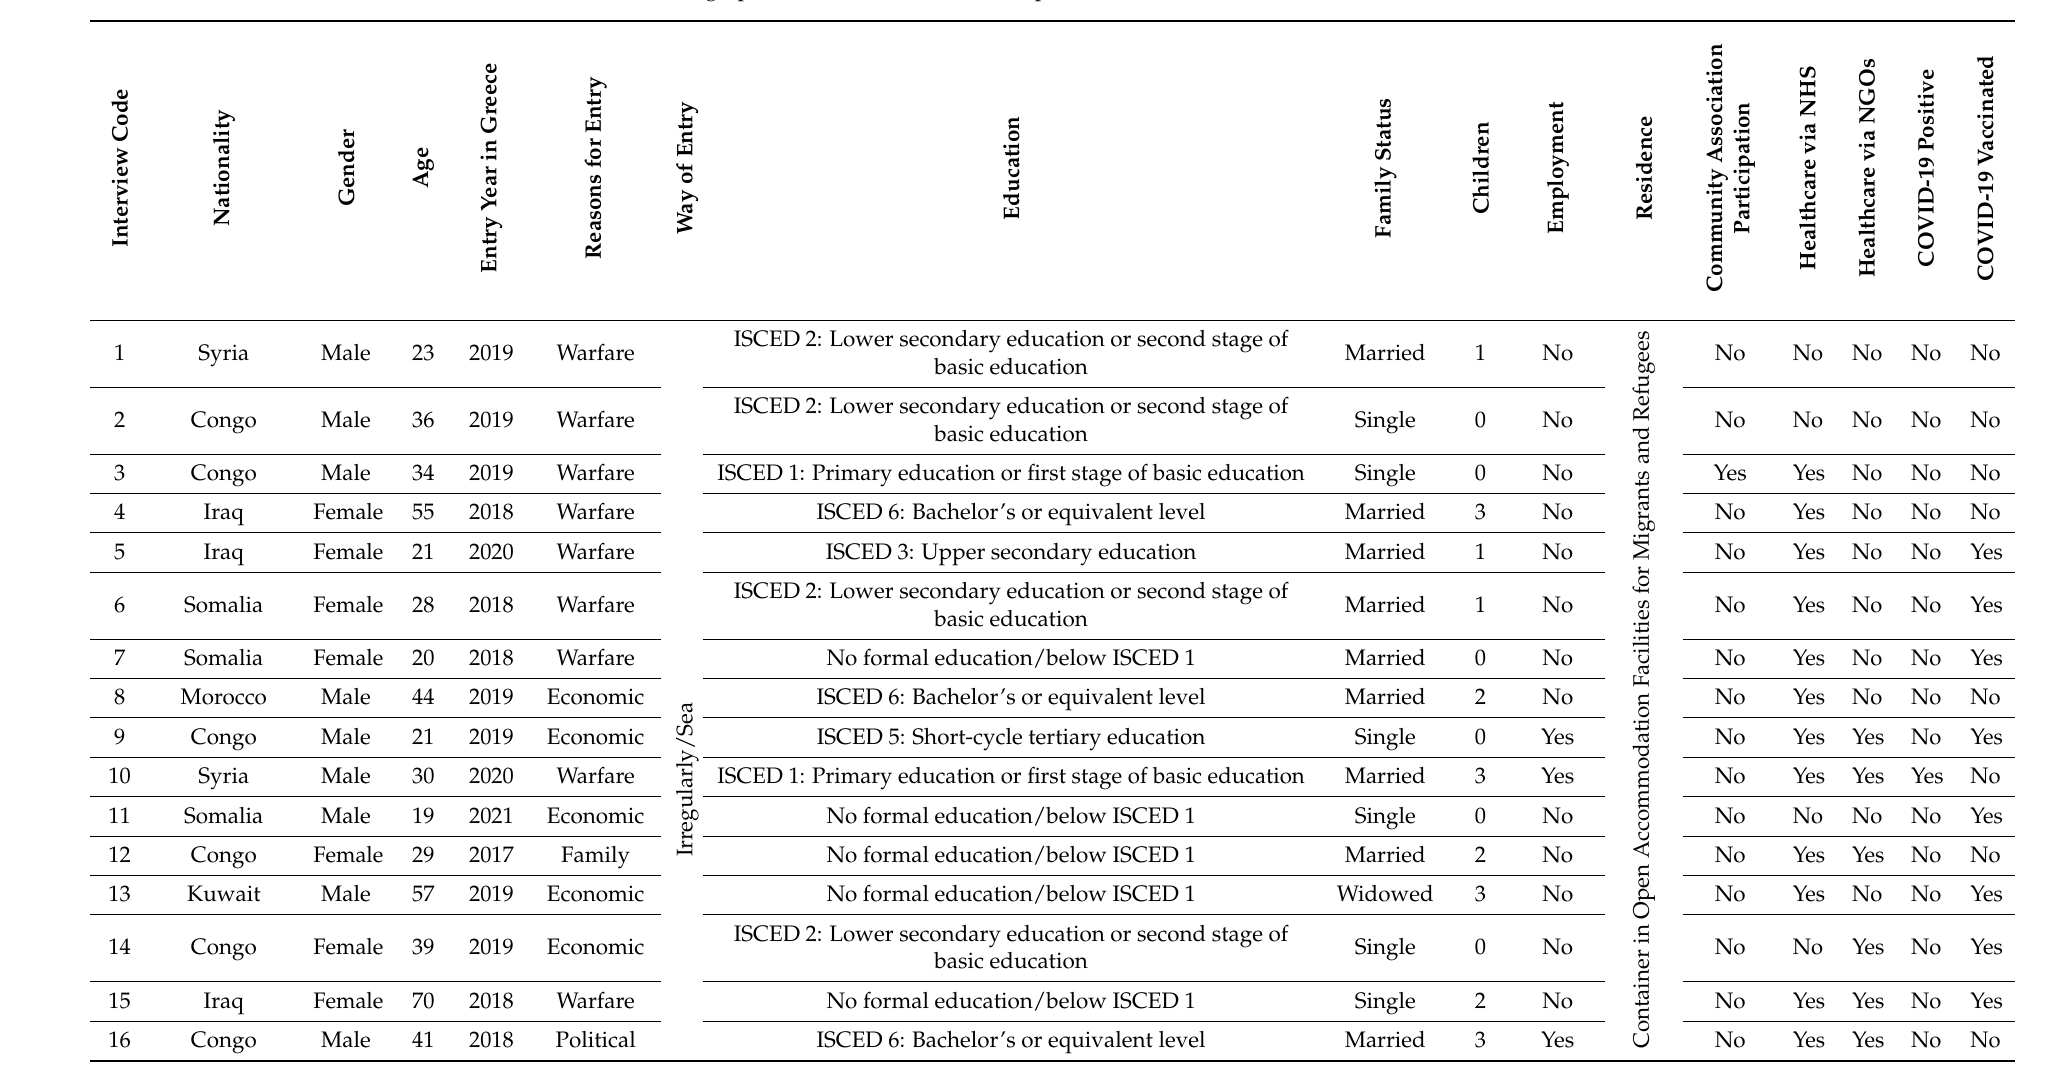
Table 2. The social and demographic characteristics of the